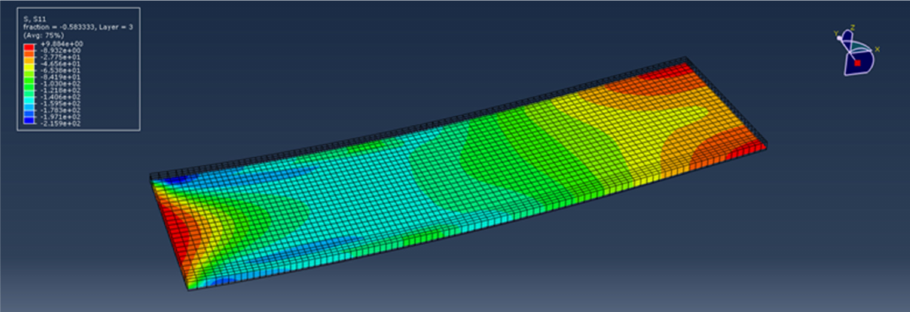
Figure 14. Longitudinal stress distribution in ply 3 of a composite beam at maximum impact force during the impact of a 0.3 kg mass hitting with 4 m/s initial